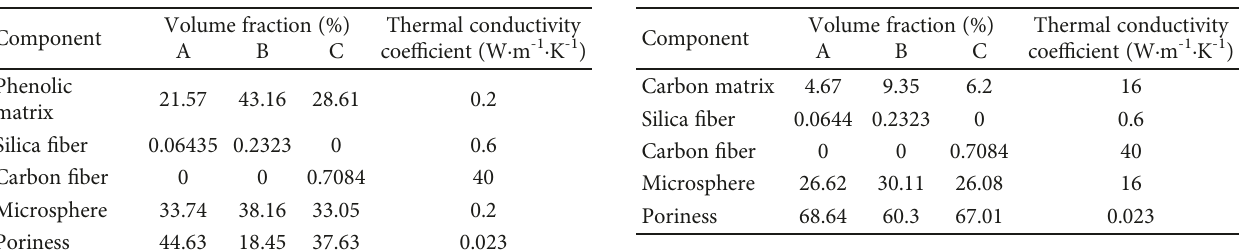
Table 1: Each component ’ s parameters of the ablation material ’ s original layer.